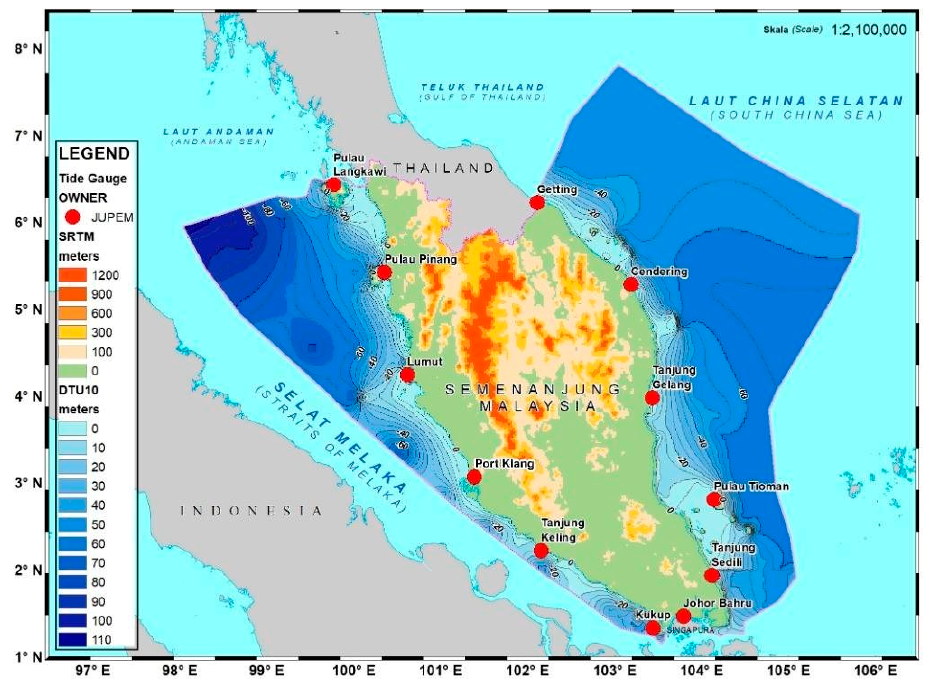
Figure 1. Land and marine extent of Peninsular Malaysia. A solid pink line indicates the continental shelf limits. TG locations are indicated by red circles. Topographic heights and seabed depth are in metres.